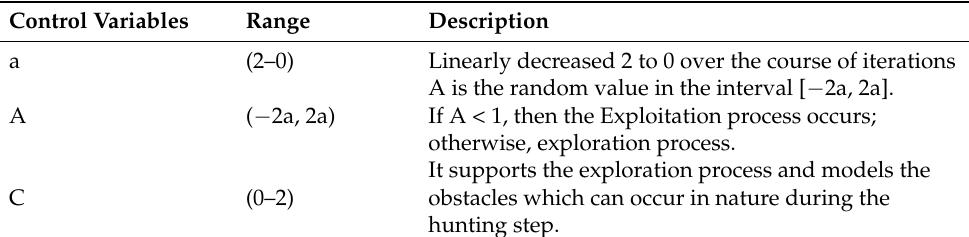
Table 1. Tuning Parameters for GWO-LS framework.